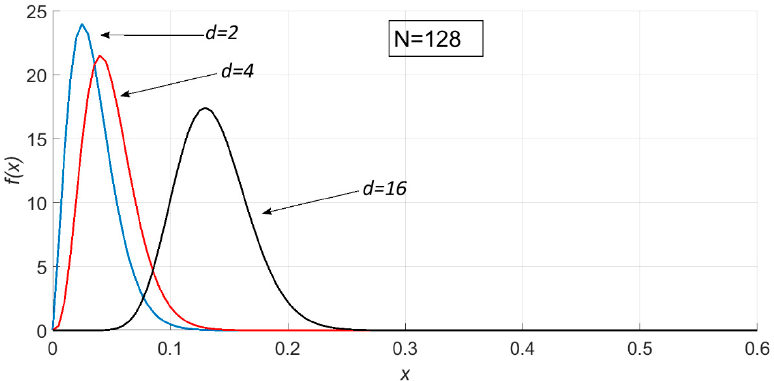
( k ) , where N = 128, δ = 5.6, δ = 20, and d = 2, 4, and 16. Figure 2. Probability density plot for Figure 2. Probability density plot for B 2 1 d , N 2.5.3. Relationship between δ 1 + δ 2 and Signal-to-Noise Ratio (SNR) δ 1 is the ratio of the energy of valid signal contained in the selected band to the noise energy of one spectral bin. δ 2 is the ratio of the energy of the valid signal not contained in the selected band to the noise energy of one spectral